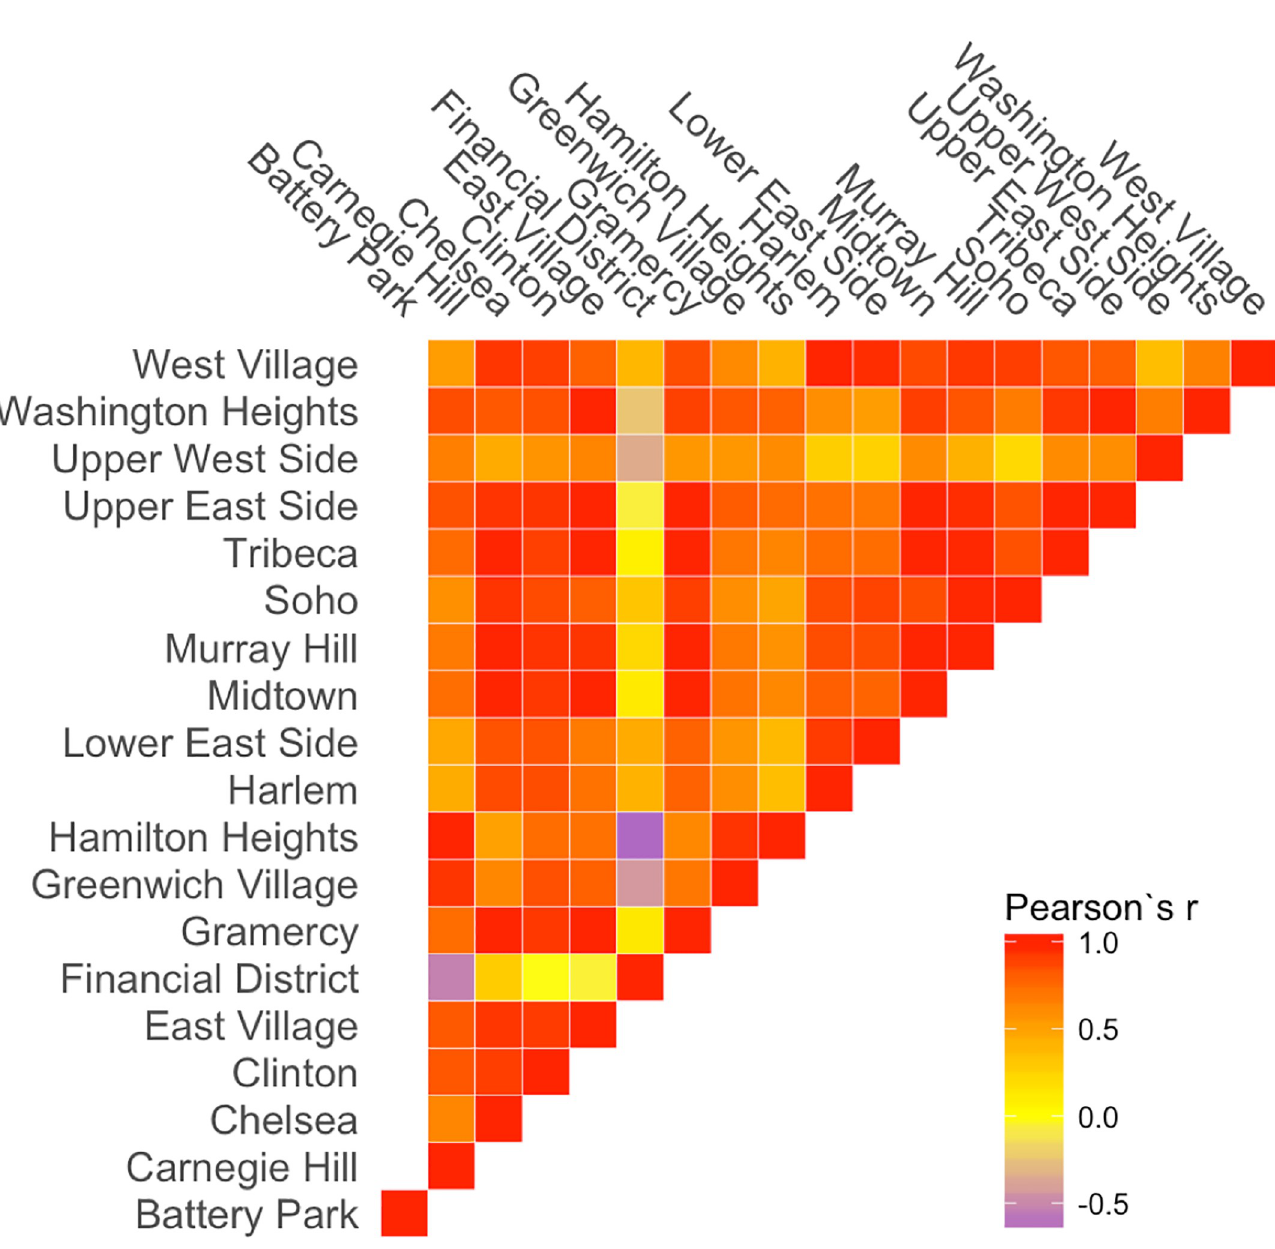
Fig 4. Pairwise Pearson correlation of neighborhoods’ coffee shop densities.